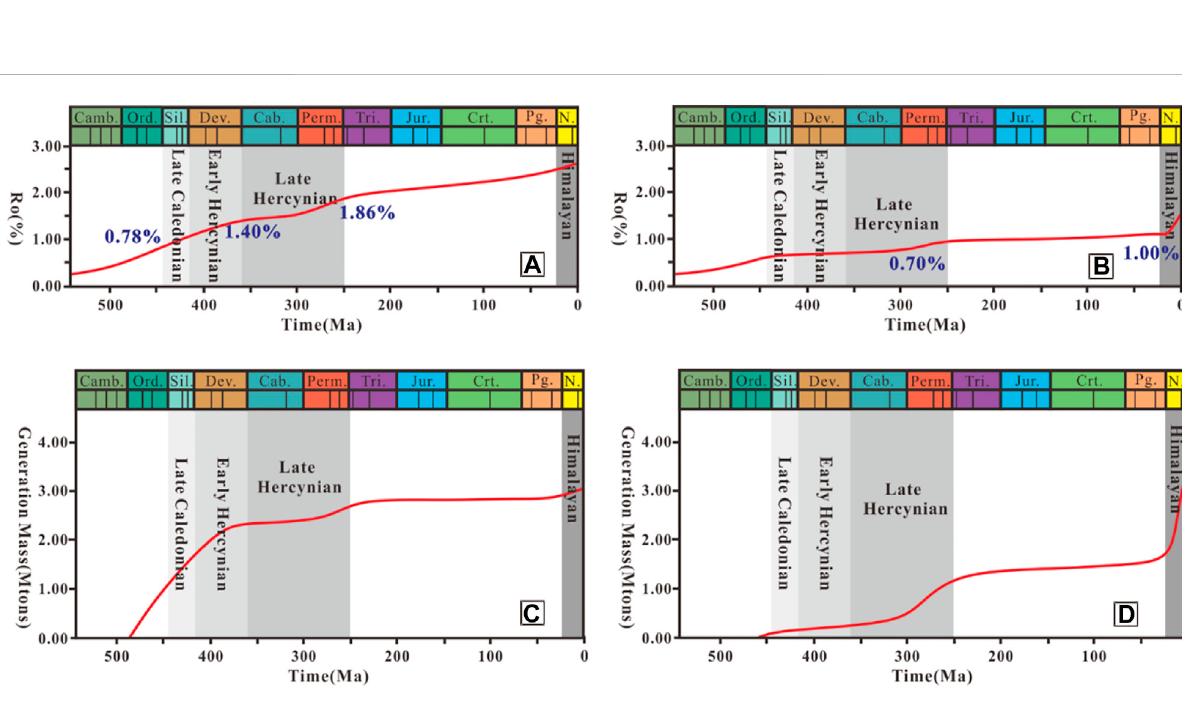
FIGURE 8 Thermal evolution history of source rocks and theamount ofhydrocarbon generation ineach period. (A) the history ofsource rocksin Shunbei Field; (B) the history of source rocks in Yakela Field; (C) the amount of hydrocarbon generation in Shunbei Field; (D) the amount of hydrocarbon generation in Yakela